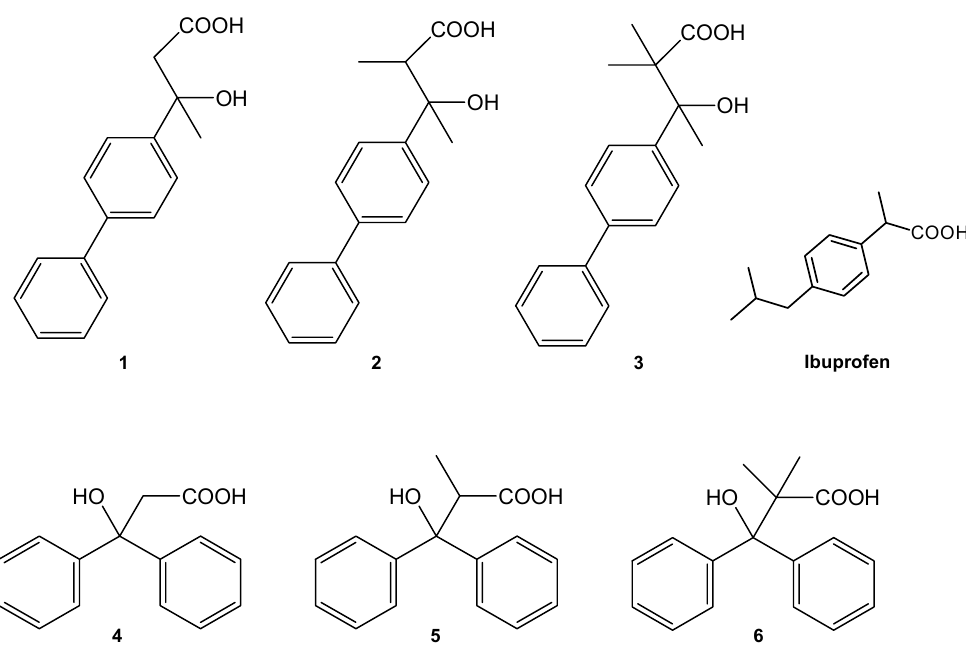
Figure 1. Structures of the studied compounds.